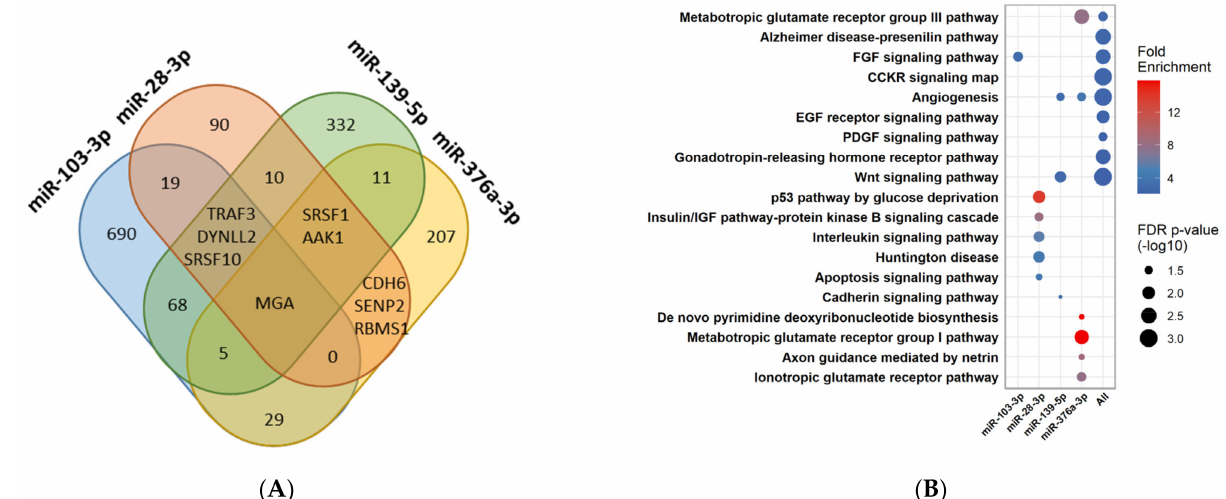
Figure 4. Overview of predicted targets and pathway enrichment analysis of each of the four miRNAs, which change differentially over time in PCOS women compared with controls, as well as a combination hereof. ( A ) Venn diagram of predicted targets identified through TargetScan v.7.2. (human). ( B ) Enrichment analysis of predicted targets. The color of the circles corresponds to the degree of positive fold enrichment, while the size of the circle corresponds to the false discovery rate (FDR) adjusted p